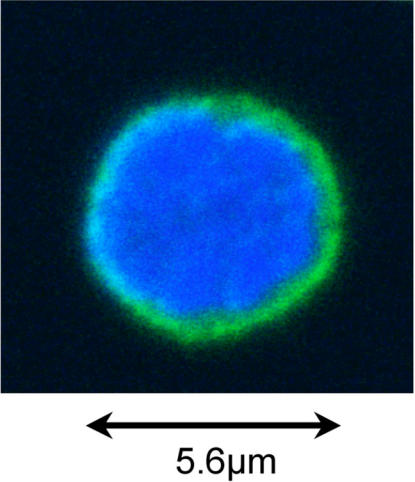
Confocal microscopy was used to determine the cytoplasmic volume of T cells to infer concentrations of signaling molecules in the cytoplasm